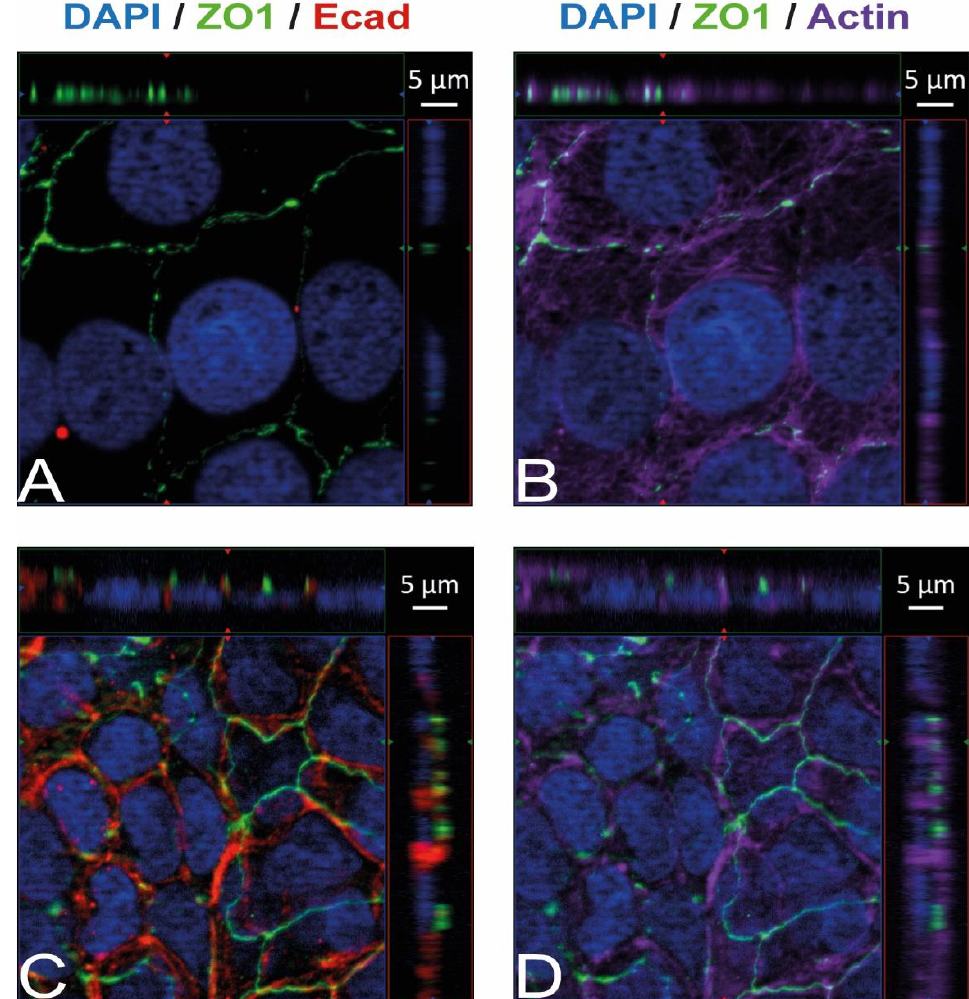
Figure 2. Ecad is present in HIBCPP cells but absent in HBMEC. Immunofluorescence staining was performed with HBMEC ( A , B ) and HIBCPP cells ( C , D ). Ecad staining ( A , C ) is shown in red; the phalloidin-stained actin cytoskeleton ( B , D ) is shown in purple. Tight junctions are visualized via the staining of ZO1 (green); nuclei are stained with DAPI (blue). All panels represent Apotome images. The center part of each image displays an xy enface view presented as a maximum intensity through the z -axis of selected slices. The top and right-side parts of each panel are cross sections through the z-plane of multiple optical slices. The apical sides of HBMEC and HIBCPP cells are oriented toward the top of the top part and towards the right of the right part of each panel,